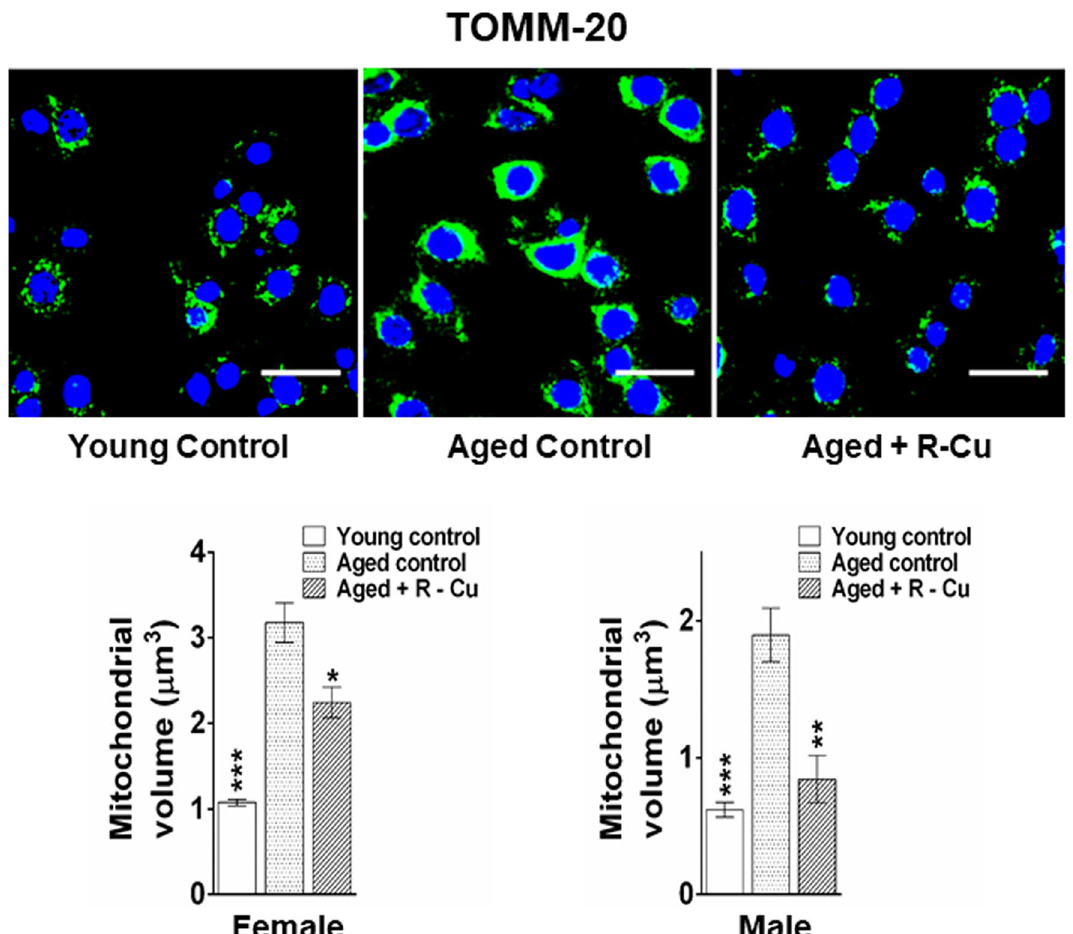
Figure 8. Increased mitochondrial dysfunction in ageing mice and its prevention by treatment with R–Cu. Representative IF images showing expression of TOMM20 (upper panel) (Scale bar = 10 µm). Quantitative histograms representing mitochondrial volume changes (lower panel). Five fields (~ 2000 mitochondria) were analysed and average volumetric change was estimated using IMARIS software 7.2.3 (http:// www. bitpl ane. com, Bitplane Technologies, AG). Bars represent mean ± SEM values. N = 4 animals in each group of both sexes. Values in young controls and R–Cu treated ageing animals were compared with those of ageing controls, and statistical analysis was performed by two-tailed Student’s t test. * p < 0.05; ** p < 0.01; *** p <